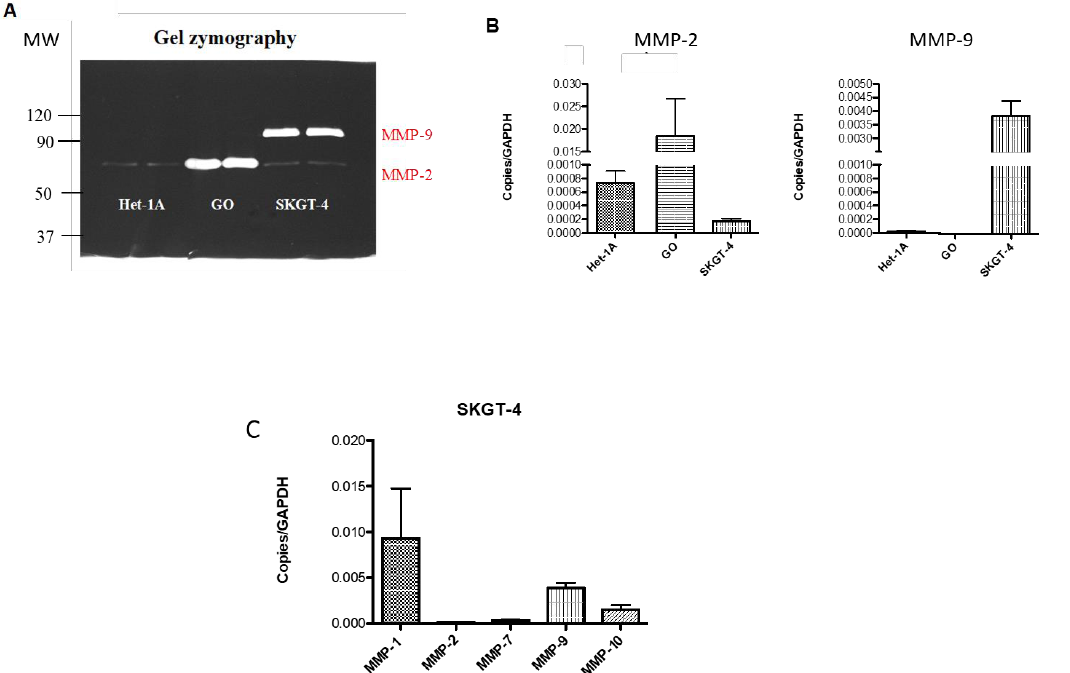
Figure 3. Basal activity and expression of matrix metalloproteinases (MMPs) in oesophageal cells. ( A ) Representative zymography from non-stimulated Het-1A, GO and SKGT-4 cells and quantitative analysis ( B , C ). Expression profile of different MMPs at gene level in non-stimulated SKGT-4 cells. n = 3 for each group .